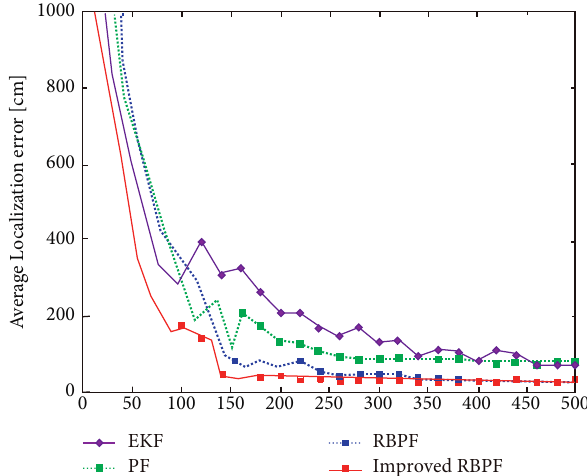
Figure 5: Average localization error with